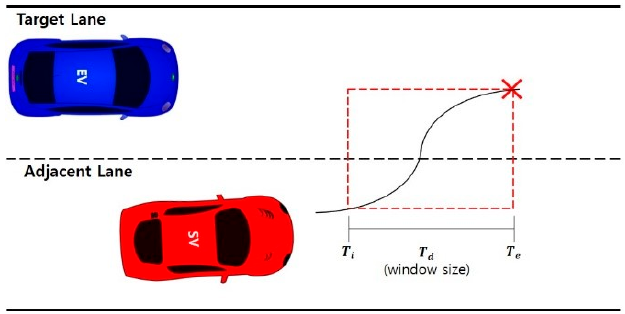
Figure 7. Define lane changing maneuvers.